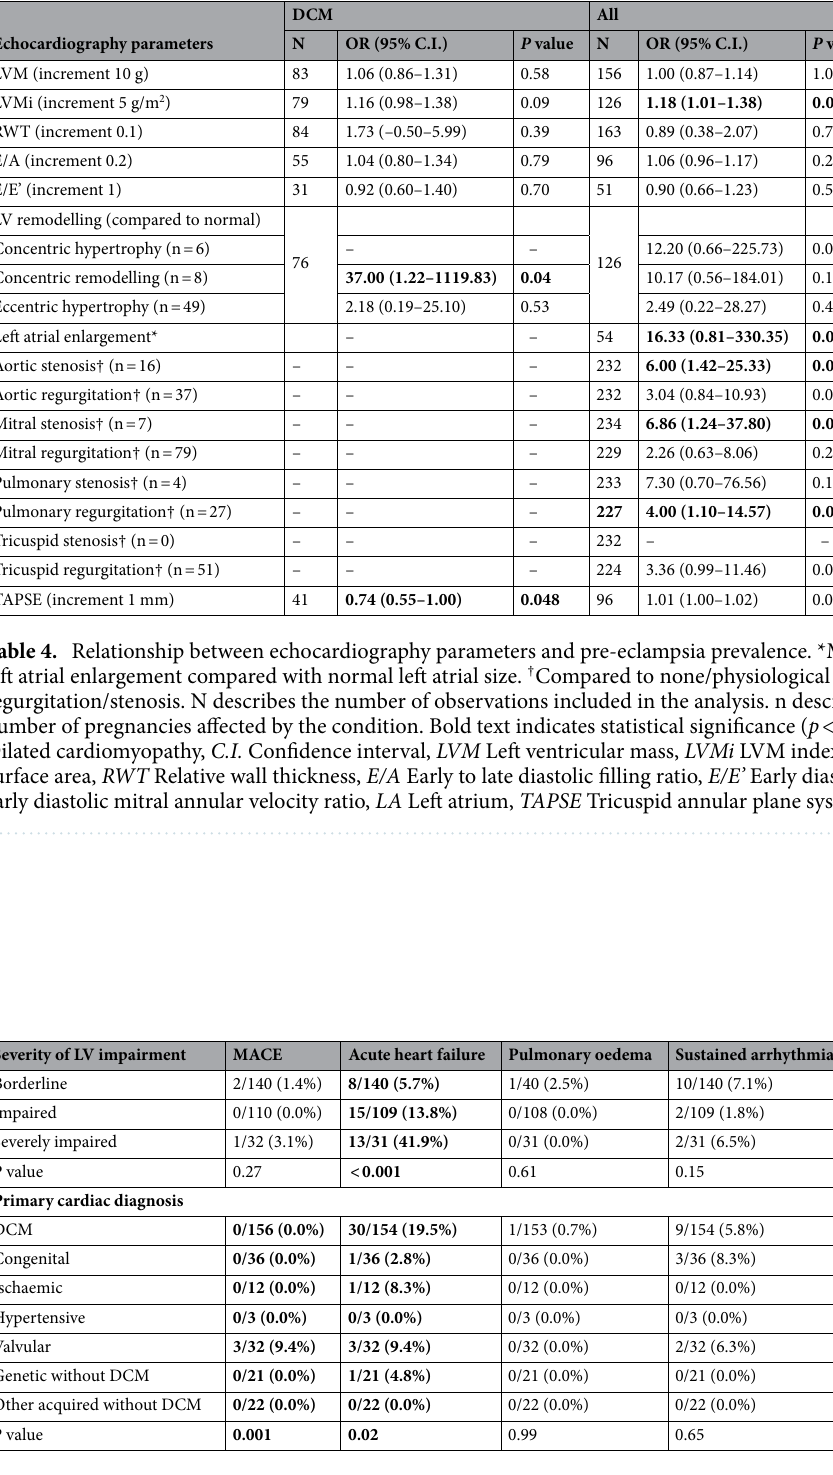
Table 5. Prevalence of adverse cardiac outcome depending on severity of LV impairment and cardiac diagnosis. Frequencies: n/N (%). Denominators vary between variables due to missing data. Severity of LVEF impairment was classified as: borderline (50–54%), impaired (36–49%) and severe (≤ 35%) 75 . Genetic causes without DCM (dilated cardiomyopathy) include: hypertrophic obstructive cardiomyopathy, arrhythmogenic cardiomyopathy and left ventricular non-compaction cardiomyopathy. Other acquired causes without DCM include: previous PPCM, drug-induced and inflammatory. P values represent comparison between LVEF impairment categories and cardiac diagnoses using Chi-square test. Bold text indicates statistical significance ( p < 0.05). LVEF Left ventricular ejection fraction, SGA Small for gestational age, FGR Fetal growth restriction; DCM Dilated cardiomyopathy.